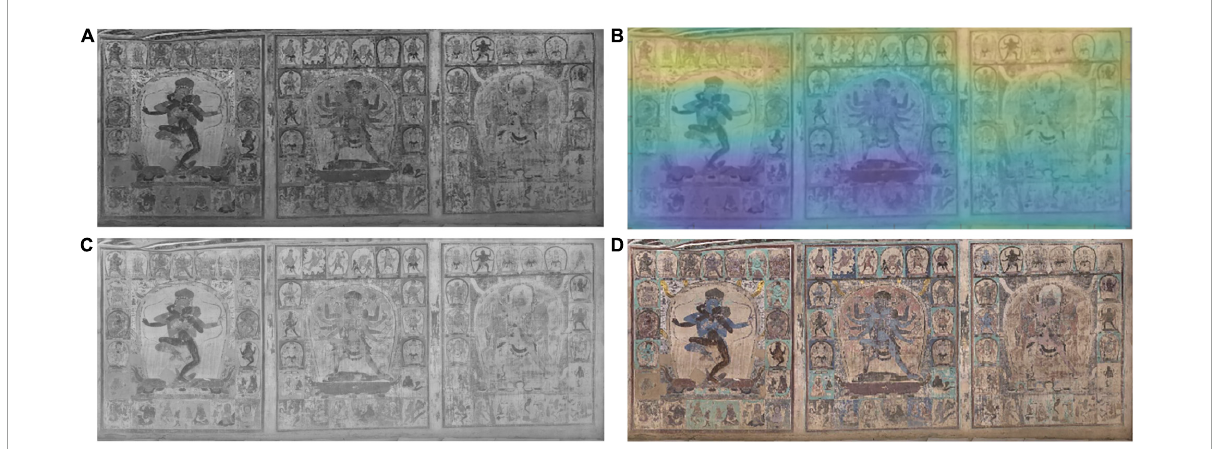
FIGURE5 The intermediate results of illumination compensation for murals taken under ambient lighting conditions. (A) The brightness channel in HSV space, (B) estimated illumination field, (C) illumination compensation in brightness channel, (D) restored mural image by illumination compensation.